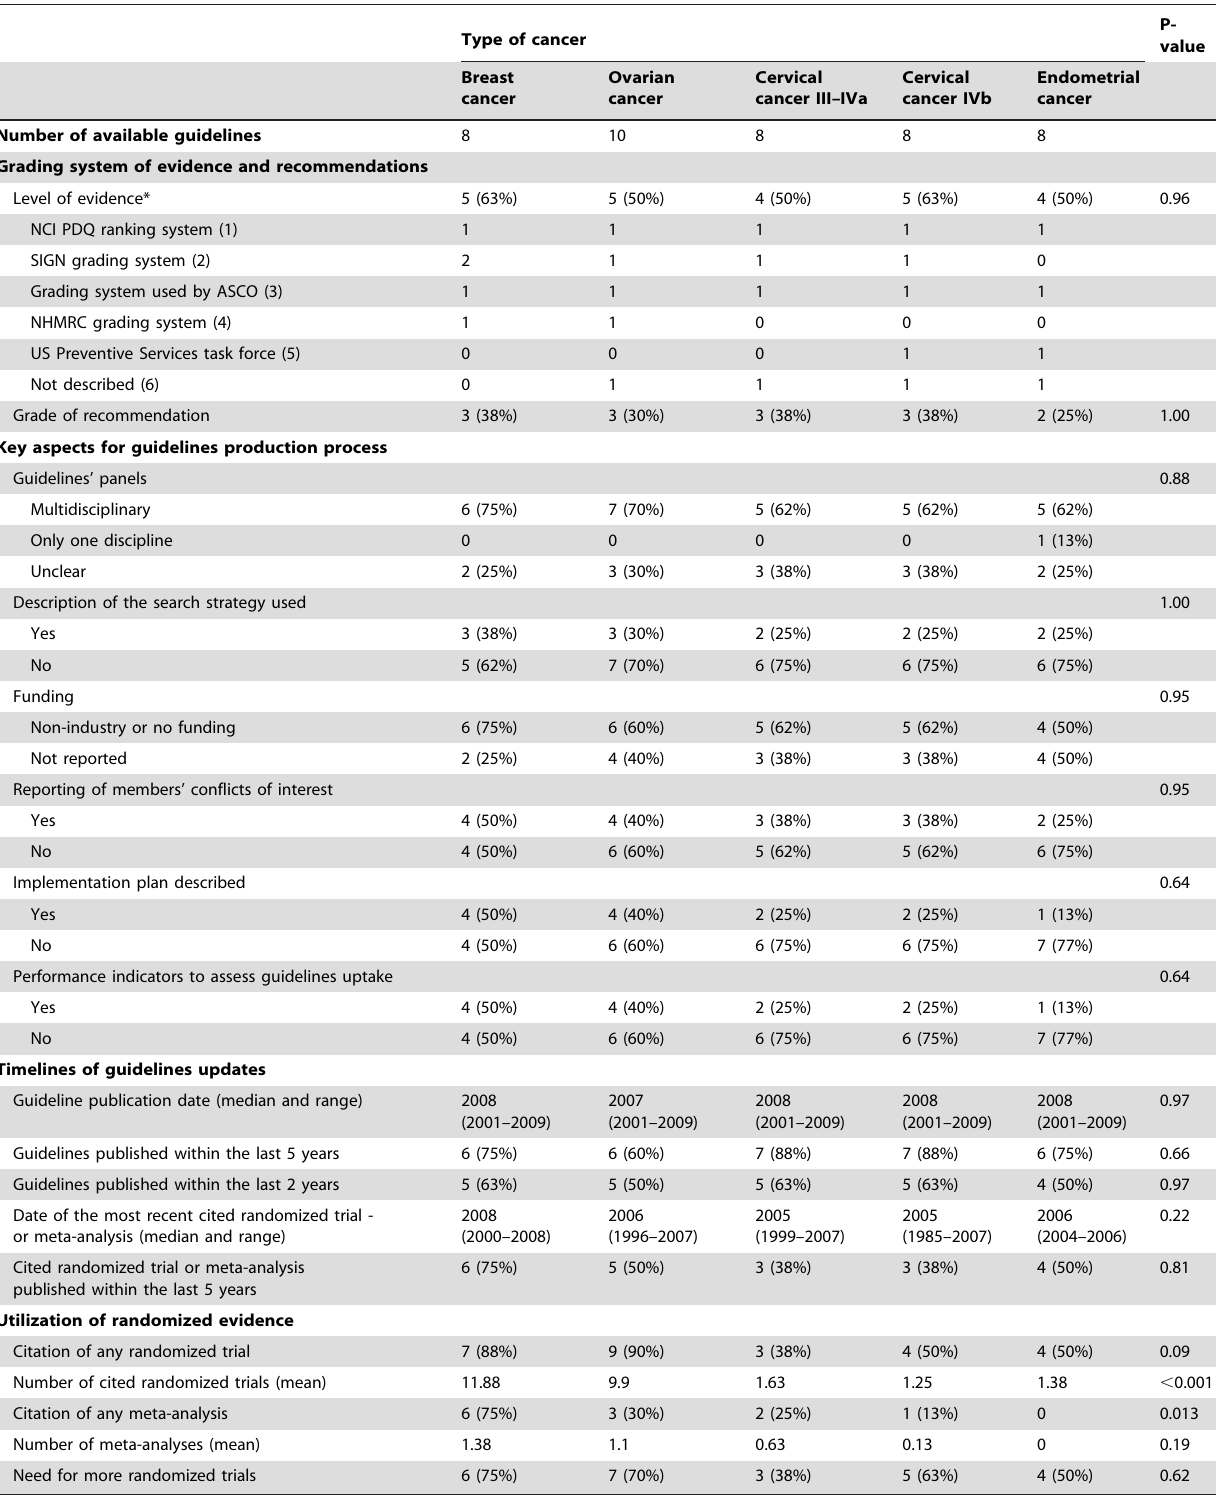
Table 3. Methods of development and utilization or randomized evidence in guidelines for advanced gynecological